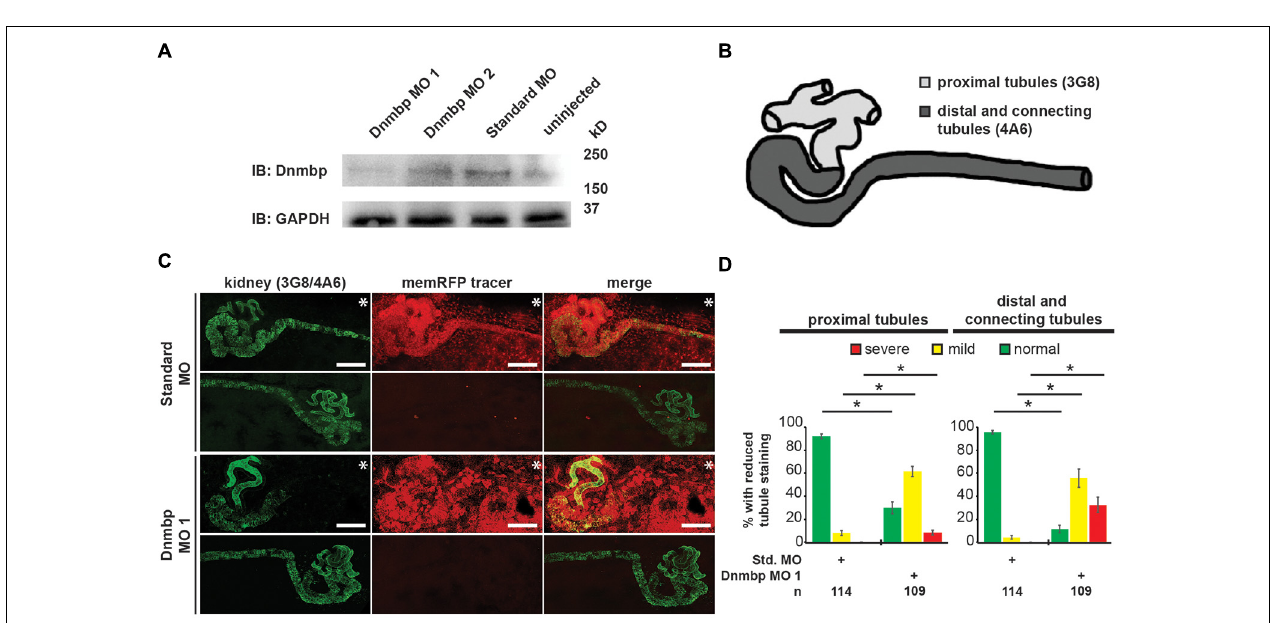
Frontiers in Physiology |